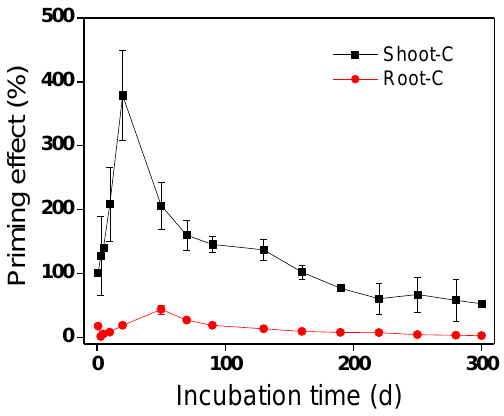
Figure 4. Priming effect of 13 C-labelled plant residues over the 300-day incubation period. Values and error bars represent means ± SE ( n = 4). Shoot-C, unlabelled paddy soil supplemented with 13 C-labelled shoot residue; root-C, unlabelled paddy soil sup- plemented with 13 C-labelled root residue.